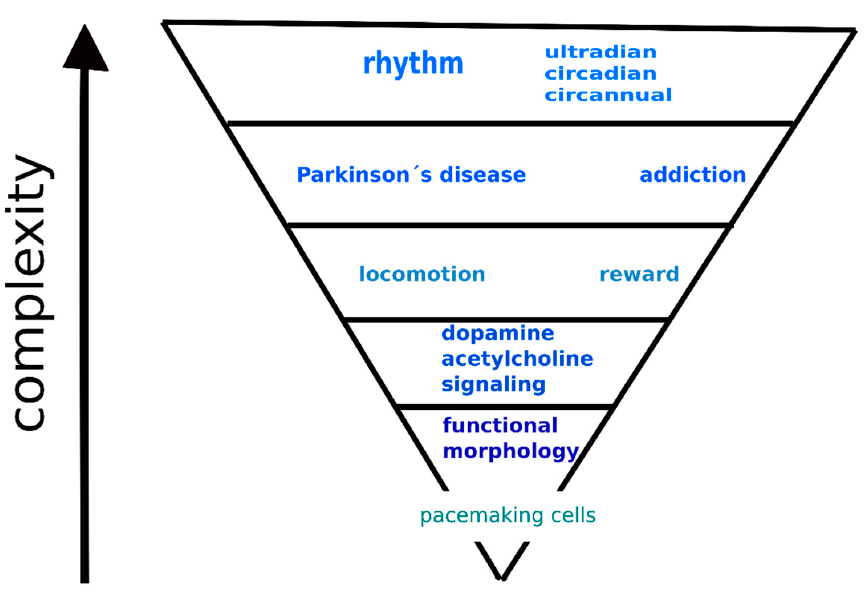
Figure 2. Hierarchical model of striatal interactions between the dopamine and acetylcholine neuro- transmitter systems.